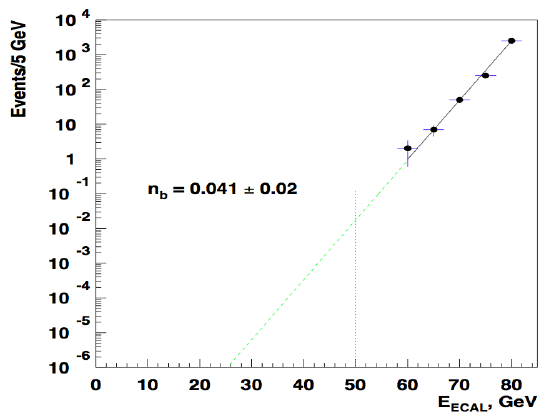
Figure 3. Invisible mode background extrapolation